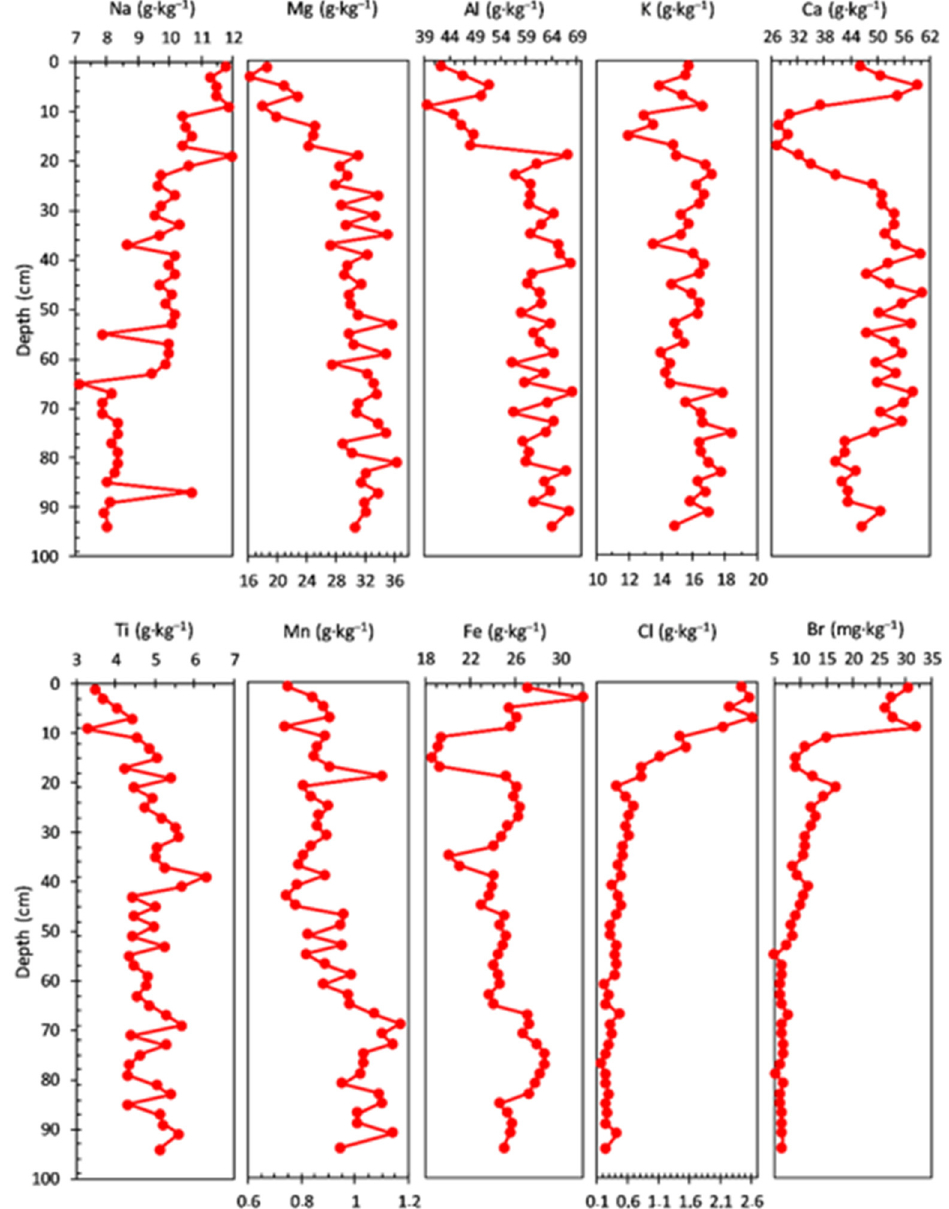
Figure 2. Vertical distribution of the main geochemical elements (Na, Mg, Al, K, Ca, Ti, Mn, Fe, Cl, Br) in the Amara Lake sediment core (94 cm